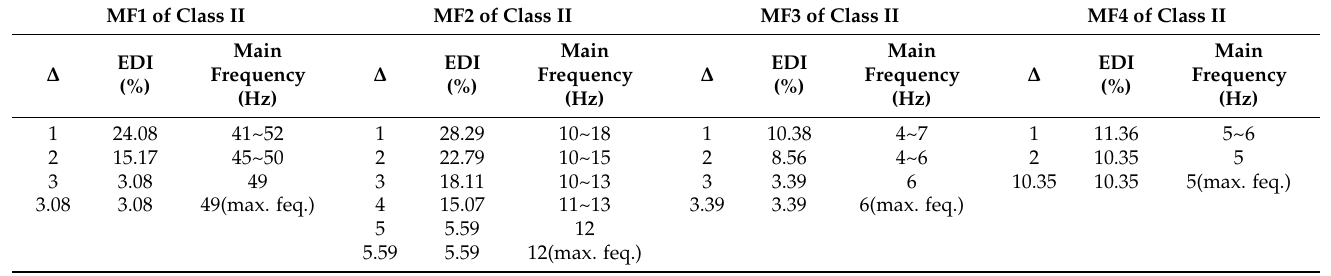
Table 5. MF1, MF2, MF3, and MF4 of class II, EDIs, main frequency bands, and the maximum frequency for threshold values of 1%, 2%, 3%, 4%, and 5%.